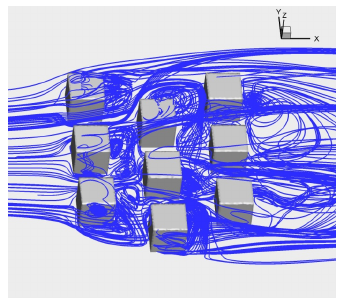
Figure 3. Prospective streamline plot of the mean flow in the array of cubes of Case 1.